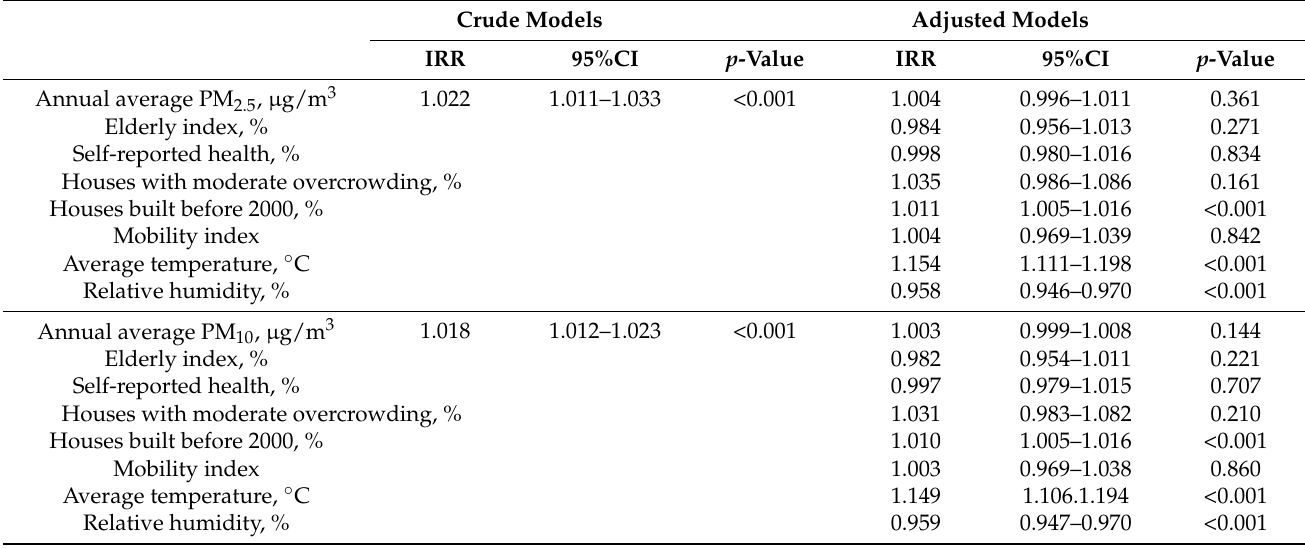
Table 3. Crude and adjusted association between COVID-19 mortality rate and PM 2.5 and PM 10 in 188 Chilean communes in